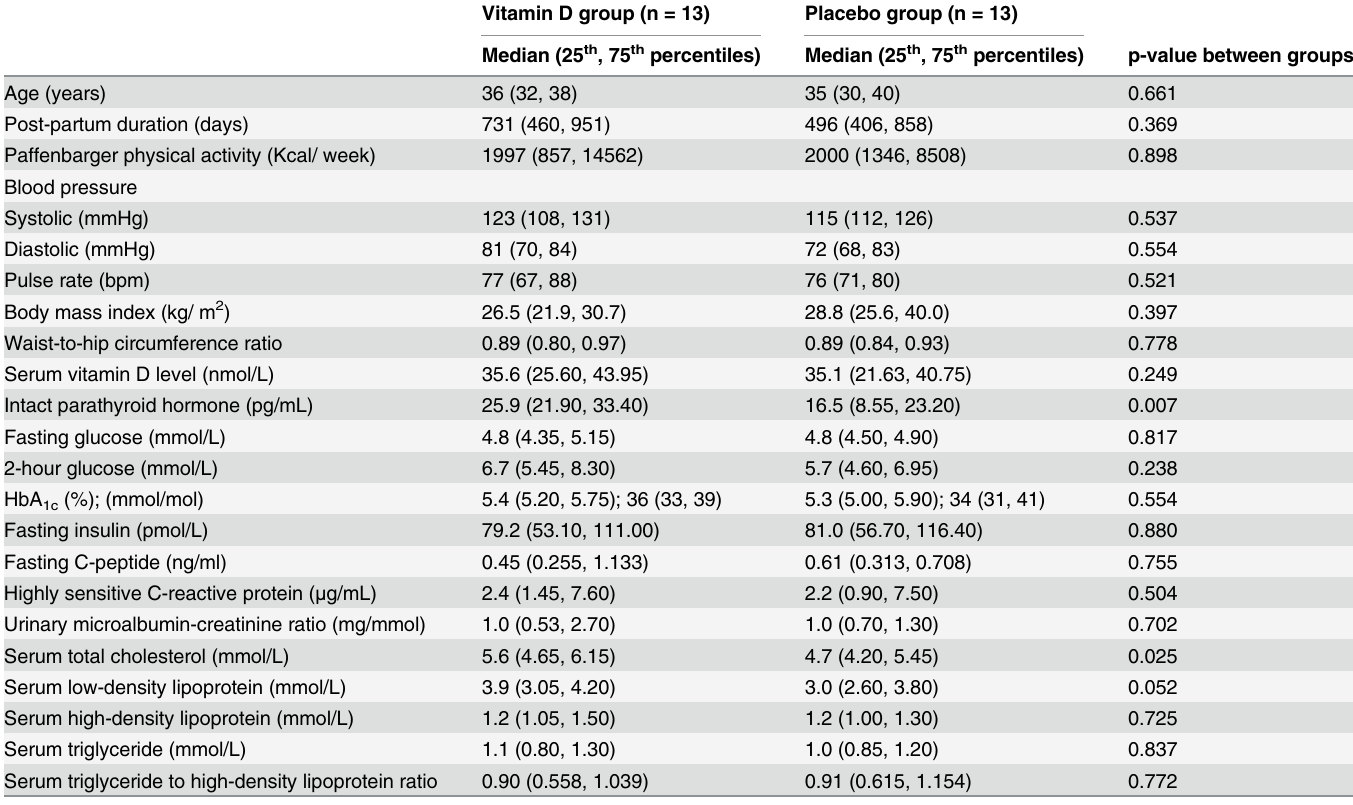
Table 1. Baseline demographics, clinical characteristics and laboratory measures of women with former GDM in both interventional and placebo groups at screening